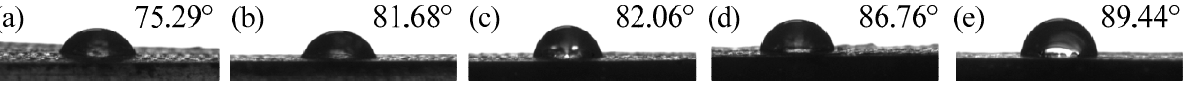
Figure 3. Brittle fracture surface of ( a ) 8% curing agent, ( b ) 10% curing agent, ( c ) 12% curing agent, ( d ) 14% curing agent, ( e ) 16% curing agent. ( d ) 14% curing agent, ( e ) 16% curing agent.